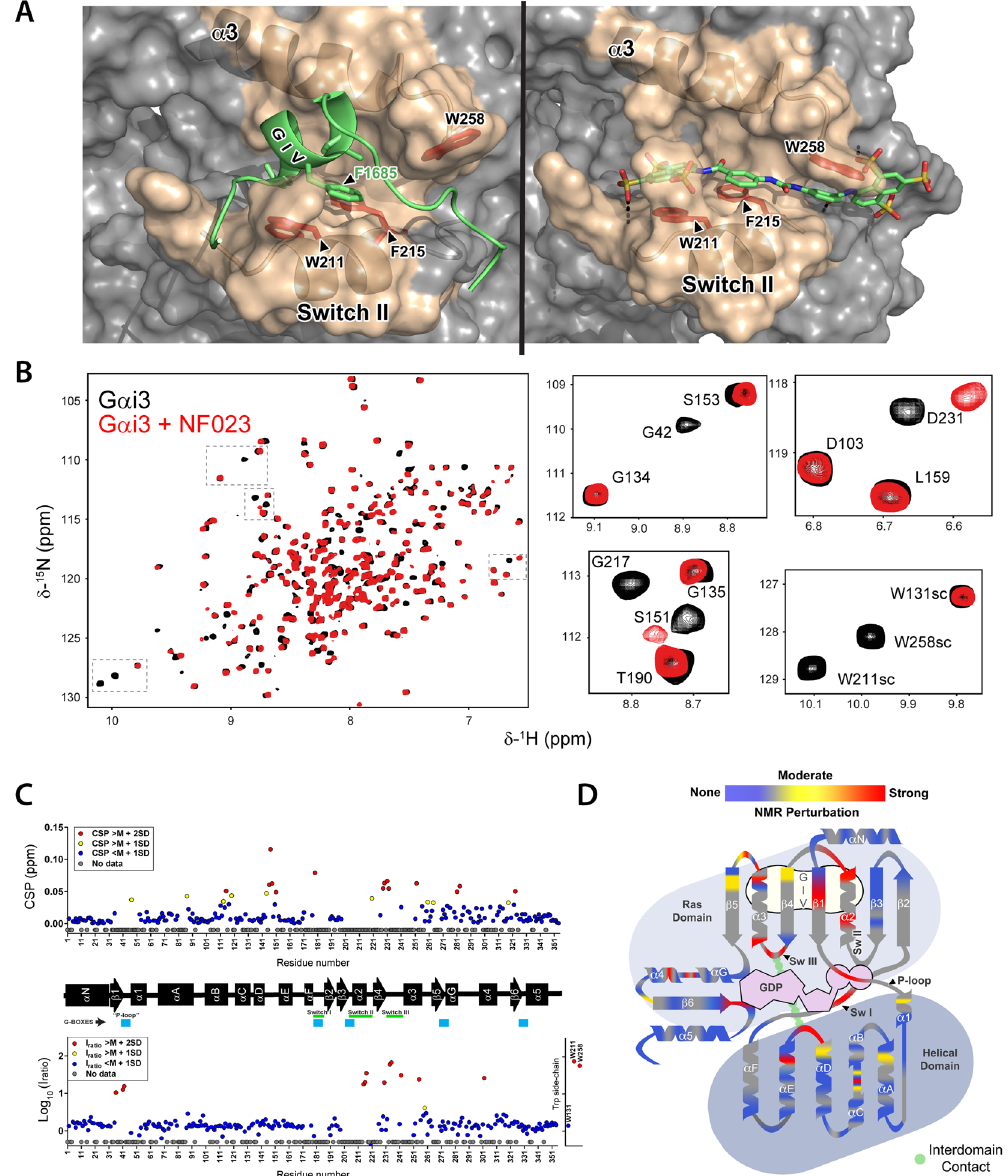
Figure 7. Solution NMR reveals structural perturbations in G α i3 upon NF023 binding at single-residue resolution. ( A ) Comparison of GIV (right) and NF023 (left) binding poses on G α i3, as seen in the virtual docking. ( B ) Overlay of 1 H- 15 N TROSY spectra of G α i3 in the presence or absence of NF023. Left , 1 H- 15 N TROSY spectra of isotopically labeled [ 2 H, 15 N] G α i3 in the absence (black) or presence of a 1:1 molar ratio of NF023 (red). Right , selected regions from the overlaid spectra depicting representative perturbations in G α i3 signals induced by NF023 binding. Some signals exhibit large chemical shift changes upon NF023 binding, whereas some other signals exhibit dramatic signal intensity reductions. ( C ) Quantification of NF023-induced perturbations of the NMR signals of G α i3. Chemical shift perturbations (CSP, top graph) or peak intensity changes (I ratio = I bound /I free , bottom graph) of the backbone amide signals of the TROSY NMR spectra in panel B. Yellow and red circles indicate residues undergoing perturbations larger than the median (M) plus one or two SD, respectively. Blue circles indicate residues with perturbations below the median (M) plus SD and grey circles indicate G α i3 residues for which no information was available. The horizontal black bar between the two graphs depicts the secondary structure elements of G α i3 and is annotated with the position of the 3 switch regions (green) that undergo conformational changes upon GTP binding and the 5 conserved G-box sequences (blue) that mediate nucleotide binding. ( D ) Schematic representation of NF023-induced NMR perturbations on G α i3. G α i3 secondary structure elements were arranged to mimic their orientation relative to the nucleotide in the three-dimensional structure. Color coding is the same as in panel C and corresponds to a composite of CSP and I ratio perturbations. For residues with changes in both CSP and I ratio measurements, the largest of the two was taken. GDP is shown in purple and the interdomain interaction between the Switch III of the Ras-like domain and the α D- α E loop of the all-helical domain is shown in green. The predicted GIV binding region is shown in light